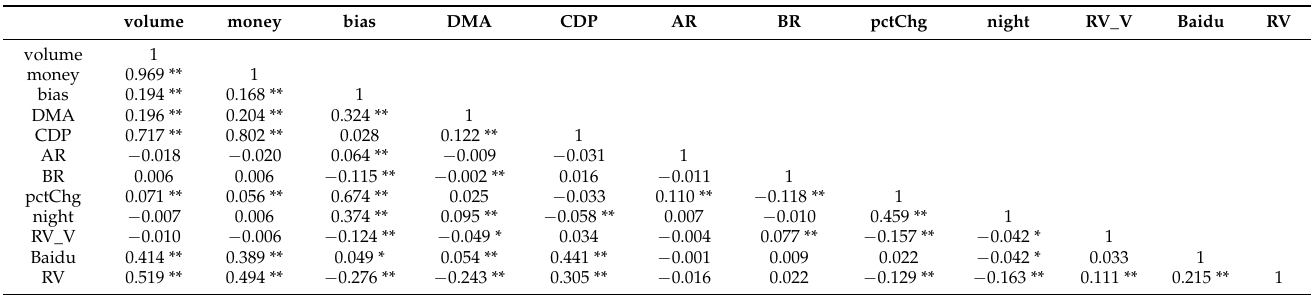
Table 5. Pearson correlation coefficient.